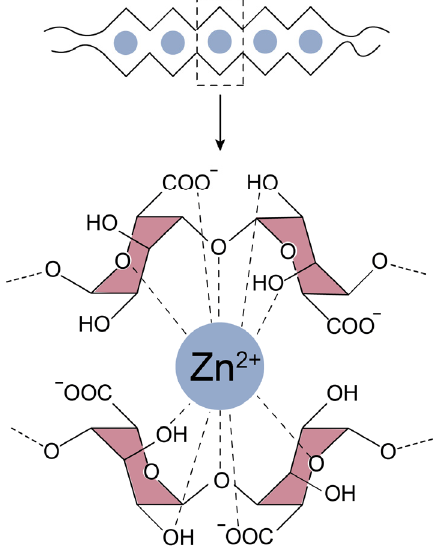
Figure 9. “Egg-box” model for A/ZnO combination.